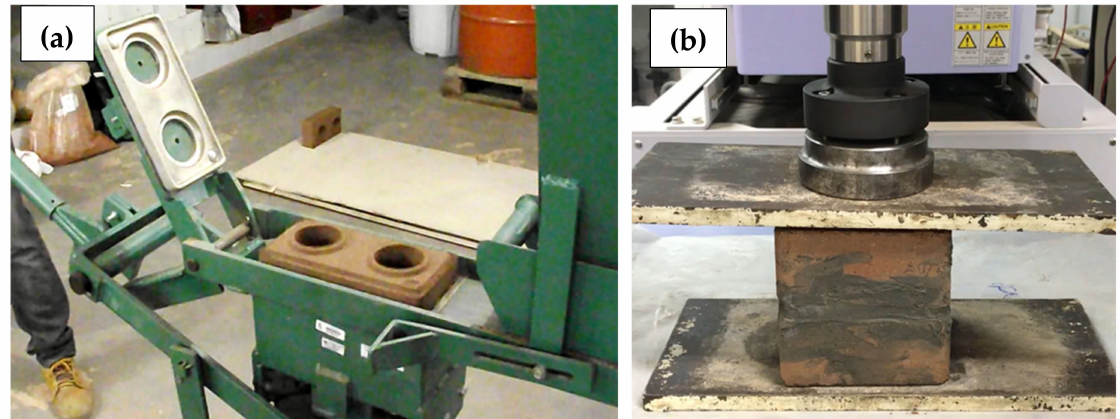
Figure 6. ( a ) Compressed Earth Block’s (CEB’s) manufacture process using a mechanical hand press; ( b ) CEB’s compressive strength